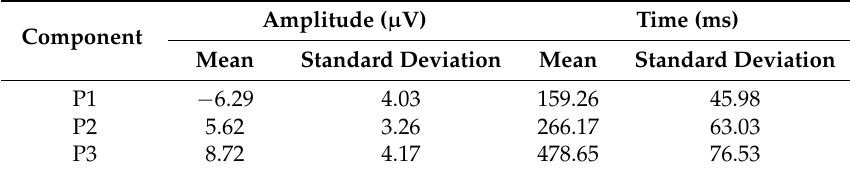
Table 1. Statistical values of the components P1, P2, and P3.